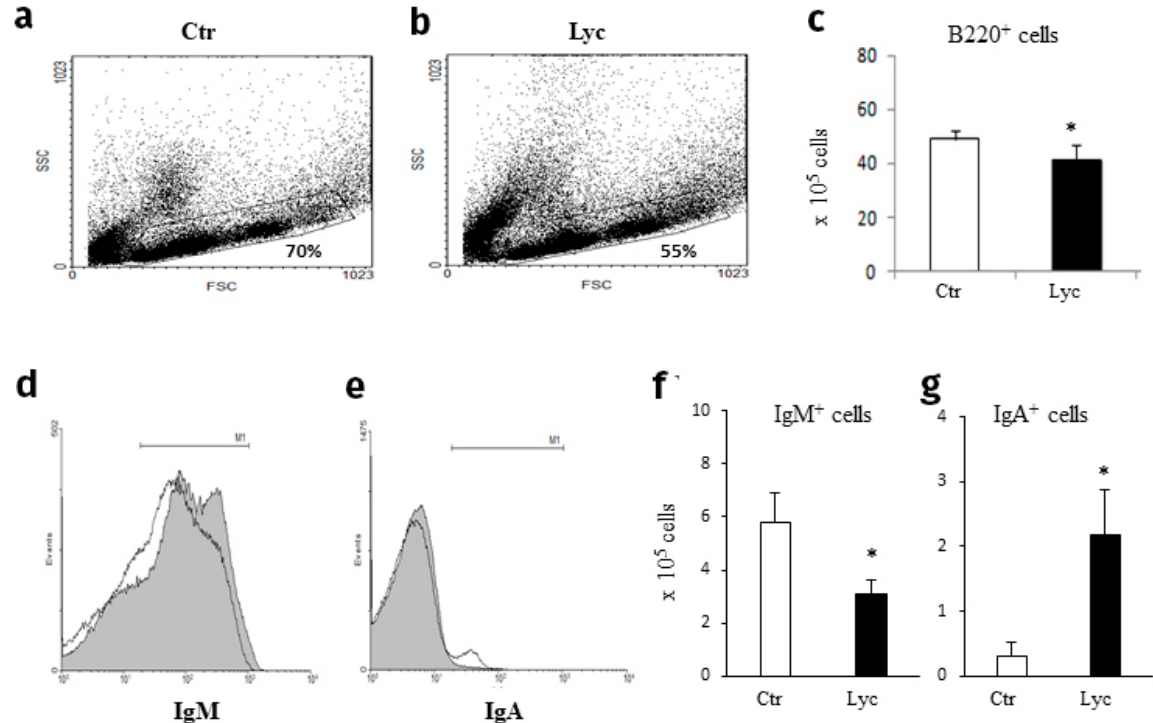
Figure 6. Effects of lycopene in the peritoneal B cell compartments. Cellular distribution of peritoneal floating cells harvested from control mice (a) and group intraperitoneally induced with lycopene 5µM (b). The number of total B220+ B cells was plotted in graph bars (c). The surface expression of IgM (d) and IgA (e) was plotted as overlaid histograms. Gray and white curves indicate control and lycopene-supplemented mice, respectively. The absolute number of IgM + B cells (f) and IgA + B cells (g) reveals possible IgM-to-IgA class switching on peritoneal B cells. n=5 mice per group. * indicates